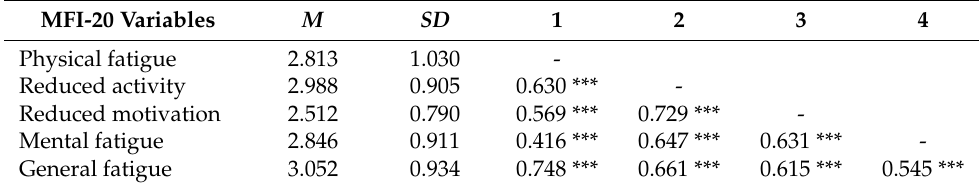
Table 5. The MFI-20: descriptive statistics and correlations between the subscales. MFI-20 Variables